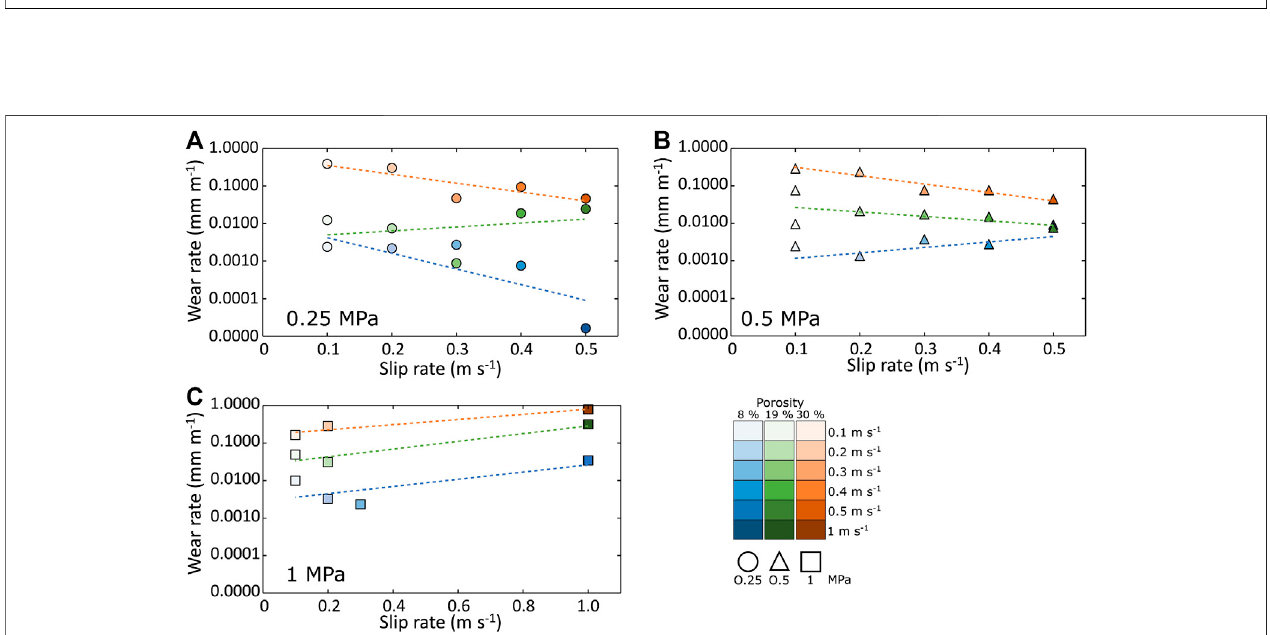
FIGURE 2 | Friction coef fi cient for each porosity material (8, 19 and 30%) calculated from data displayed in Figures 1B – D and plotted against slip rate for all porosities(colourdenotesporosity,shadeisslipratefrom0.1to1.0 m s − 1 ).Notethatfrictioncoef fi cientsincreaseatratesupto0.3 m s − 1 anddecreasewithincreasingly higher slip rates as marked with sketch lines.